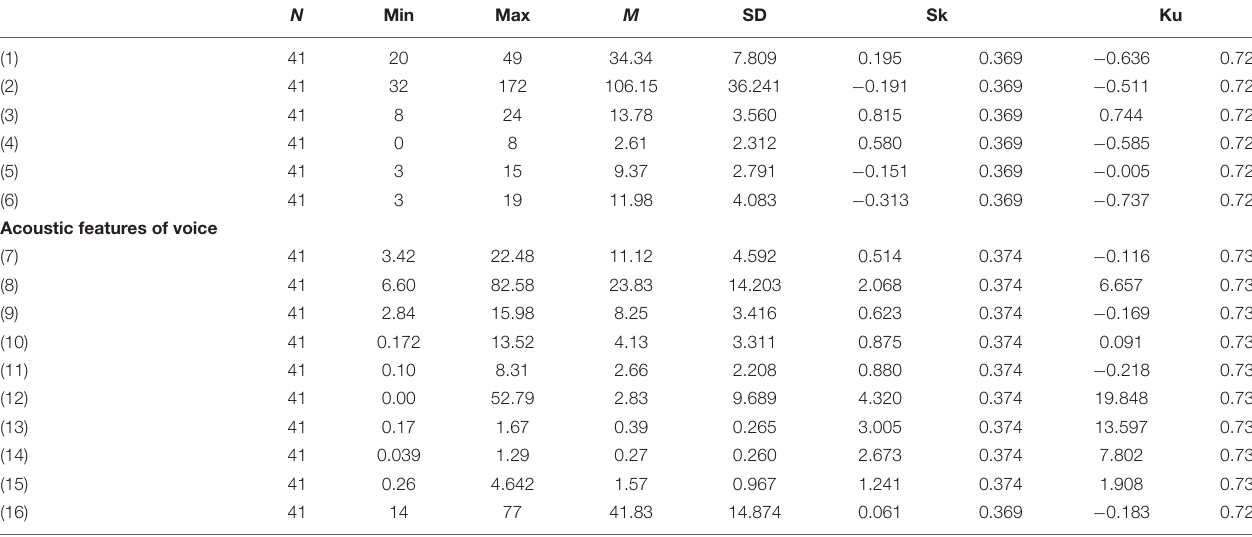
TABLE 2 | Descriptive measures of all variables used in the